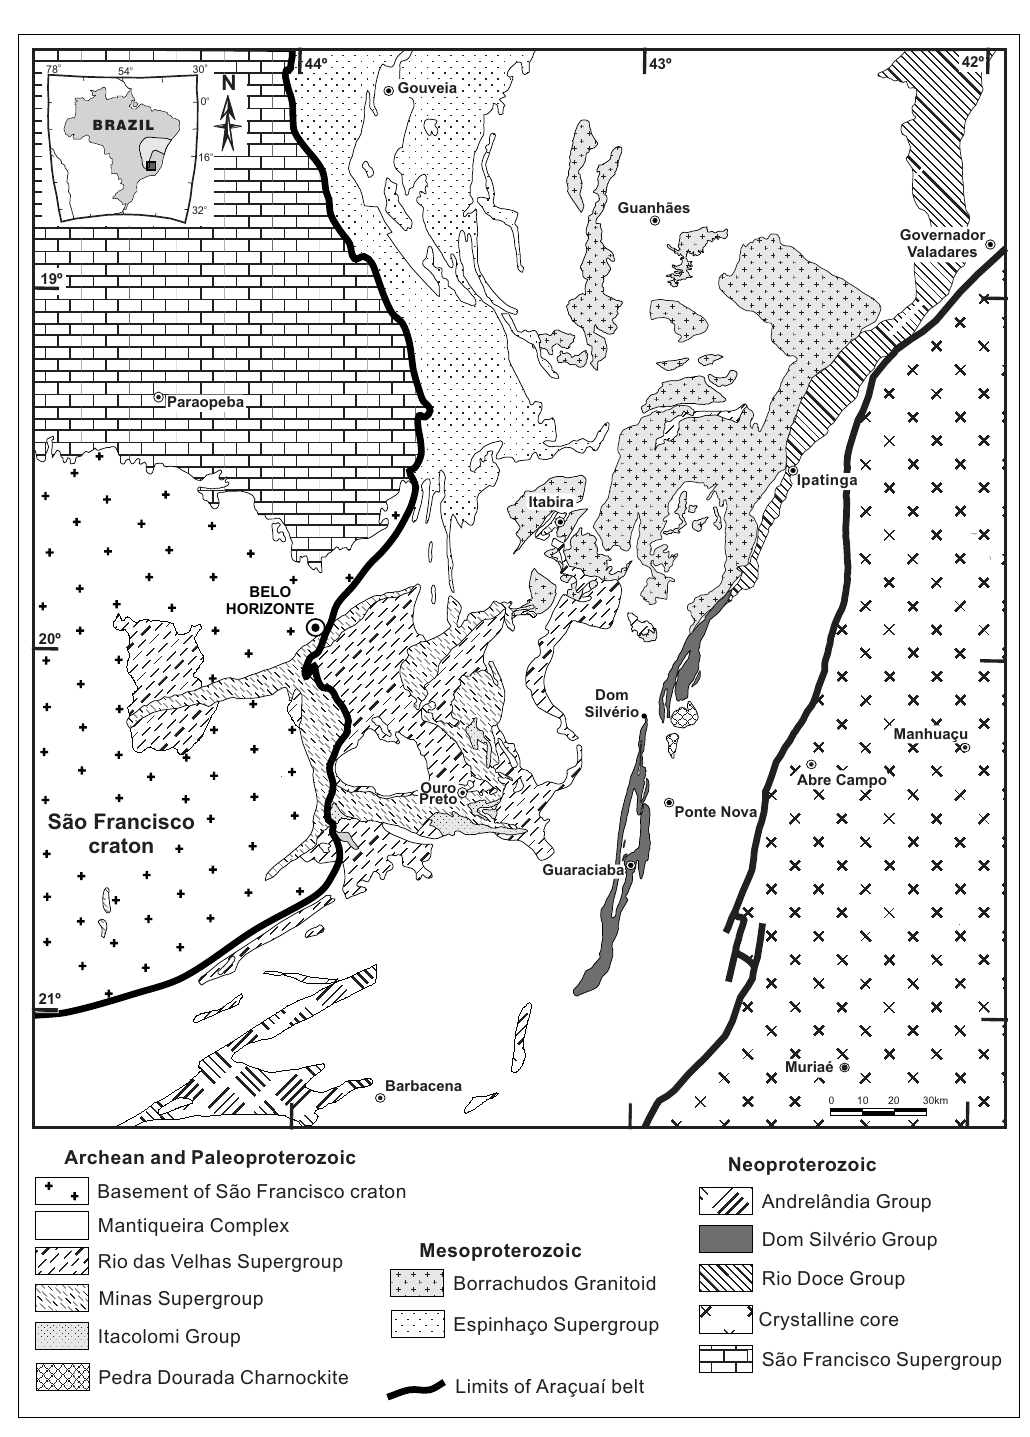
Fig. 3 – Geologic map of the southern portion of theAraçuaí belt showing the boundaries of the São Francisco craton and the crystalline core. Compiled from Machado Fº et al. (1983), Pinto et al. (1997), Grossi-Sad et al. (1997) and Peres (2000).